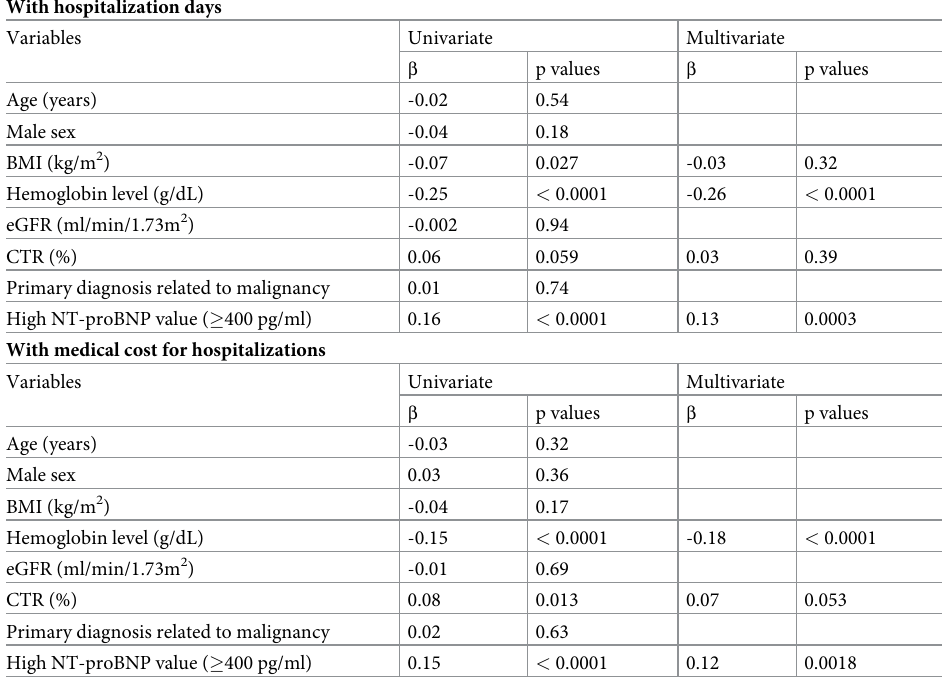
Table 3. Linear regression analysis to examine the association of the clinical factors with hospitalization days and medical cost. With hospitalization days